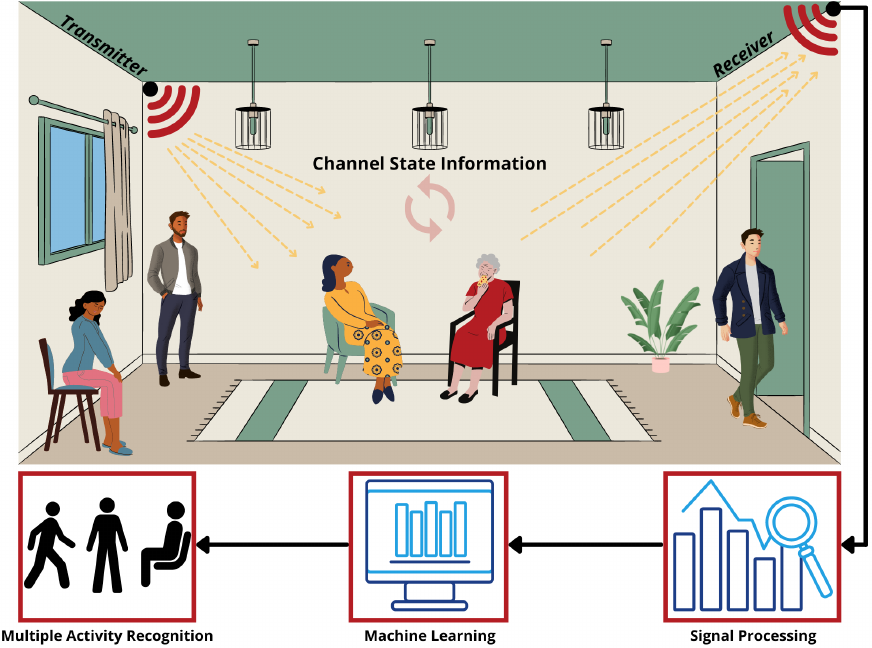
Figure 1. Proposed system concept design based on non-contact sensing technology and AI for multiple individuals’ activity recognition.